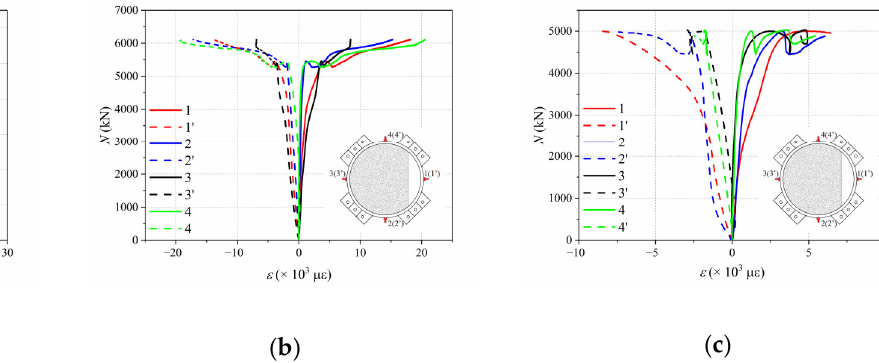
Figure 15. N- ε curves at the cross-section of a 1/2 height of BWCFST specimens with spherical-cap gap of different χ : ( a ) χ = 2.3%; ( b ) χ = 4.6%; ( c ) χ = 6.9%.